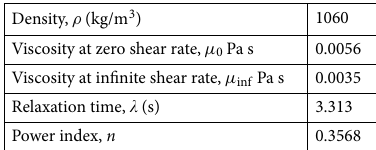
Table 1. Material properties of blood 35 .